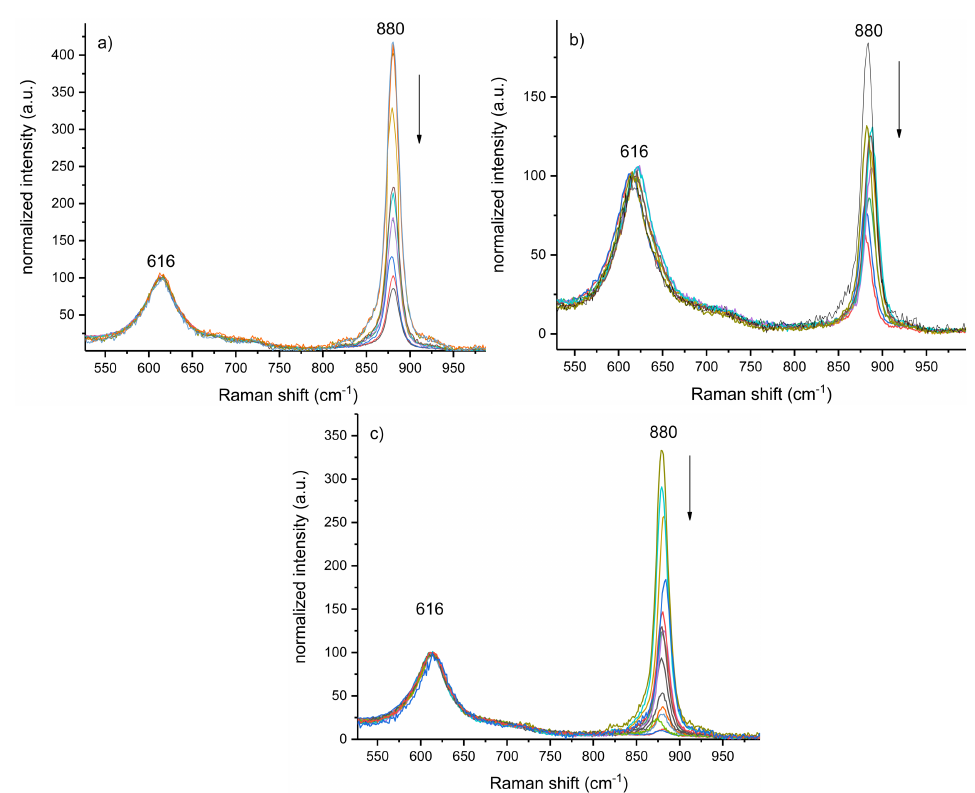
Figure A4. Raman kinetic spectra obtained by measurement of samples ( a ) OSM-0, ( b ) OSM-Al f , ( c ) OSM-Al A , ( c ) Signal changes at 880 cm − 1 —symmetric vibration between O–O in hydrogen peroxide molecule as a function of time for tested OSM. The arrow indicates the direction of the signal changes